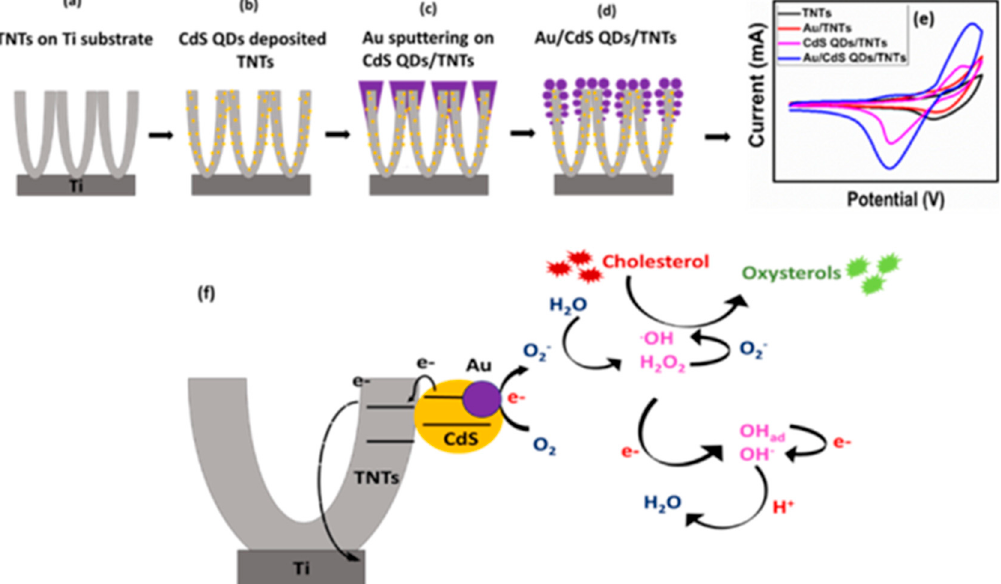
Figure 7. Schematic illustration of the ( a – d ) synthesis process of Au/CdS QDs/TNTs ( e ) CV response of different electrodes in the presence of cholesterol ( f ) oxidation reaction mechanism of cholesterol with the Au/CdS QDs/TNTs biosensor. Reprinted with permission from Ref. [59].